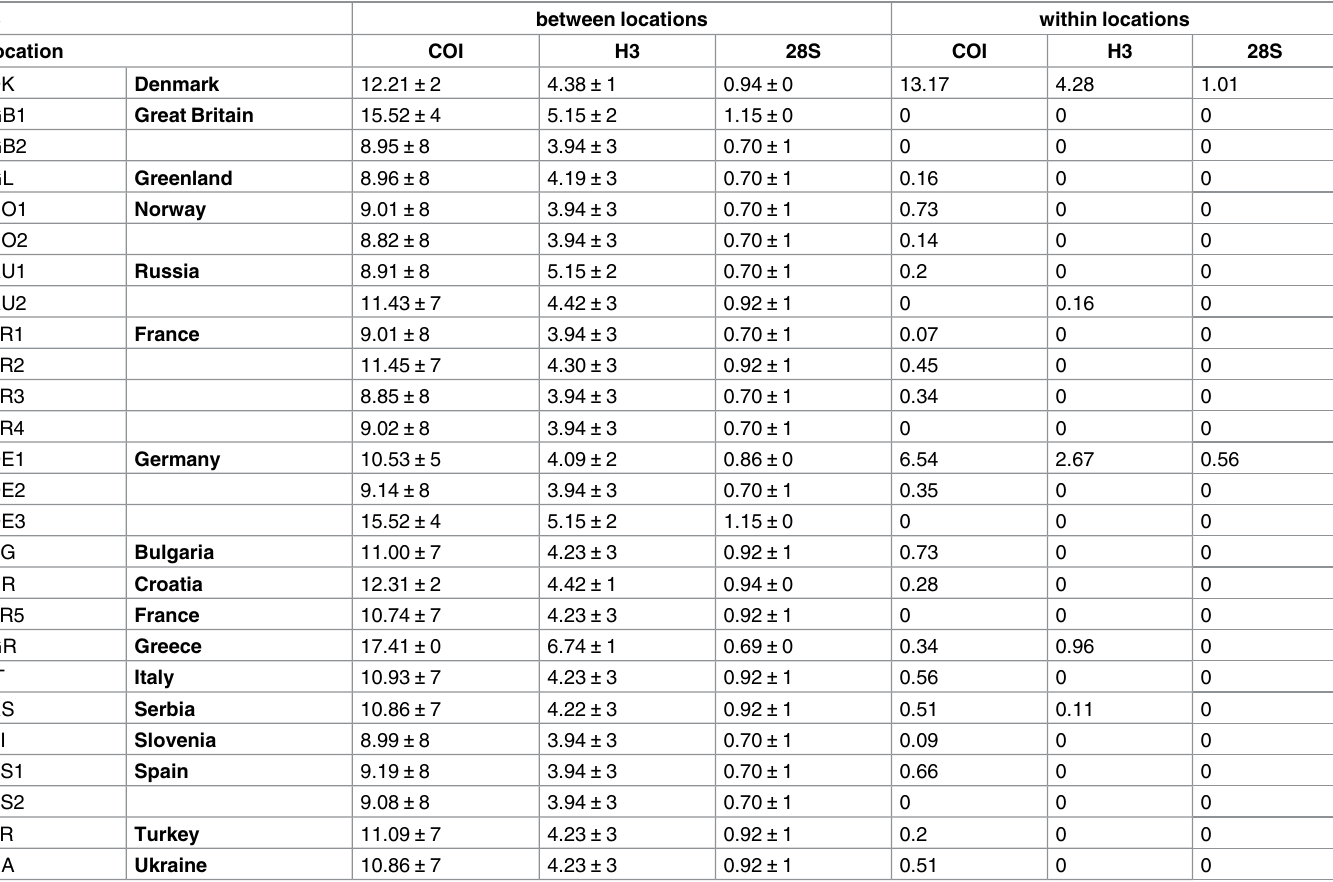
Table 3. Mean genetic distances (observed p-distances in %) of Parisotoma notabilis between and within locations in Europe for three genes. B